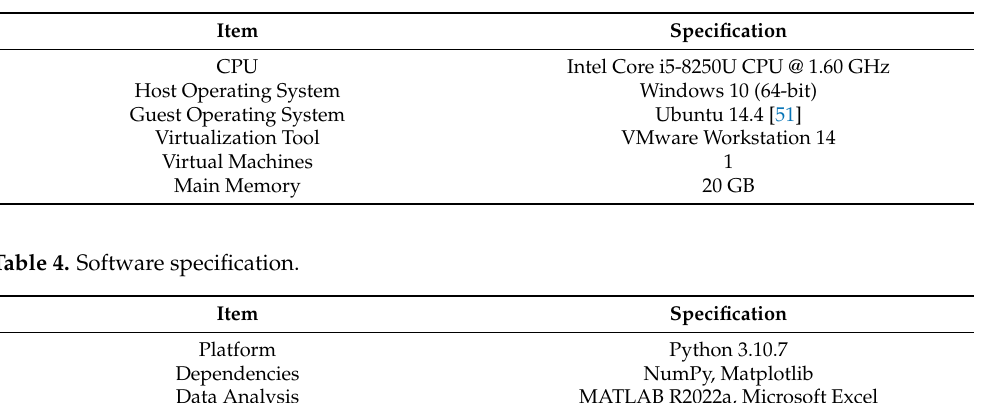
Table 3. Physical host specification.